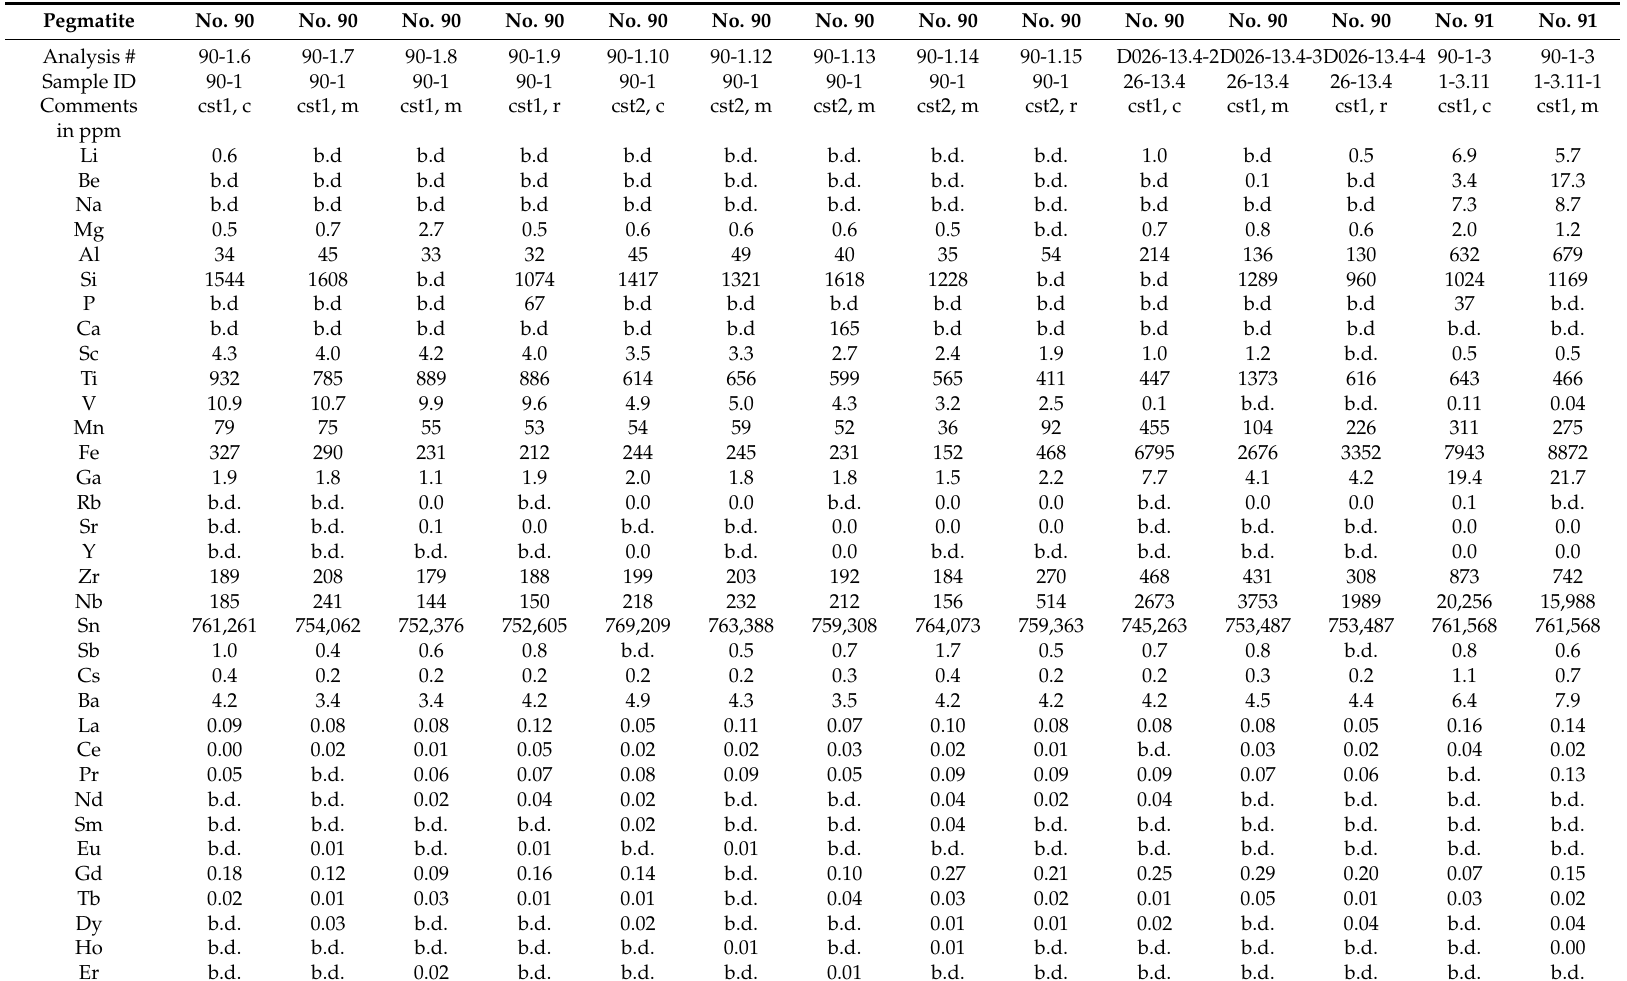
Table 5. LA-ICP-MS analyses of cassiterite from the Dahongliutan albite-spodumene